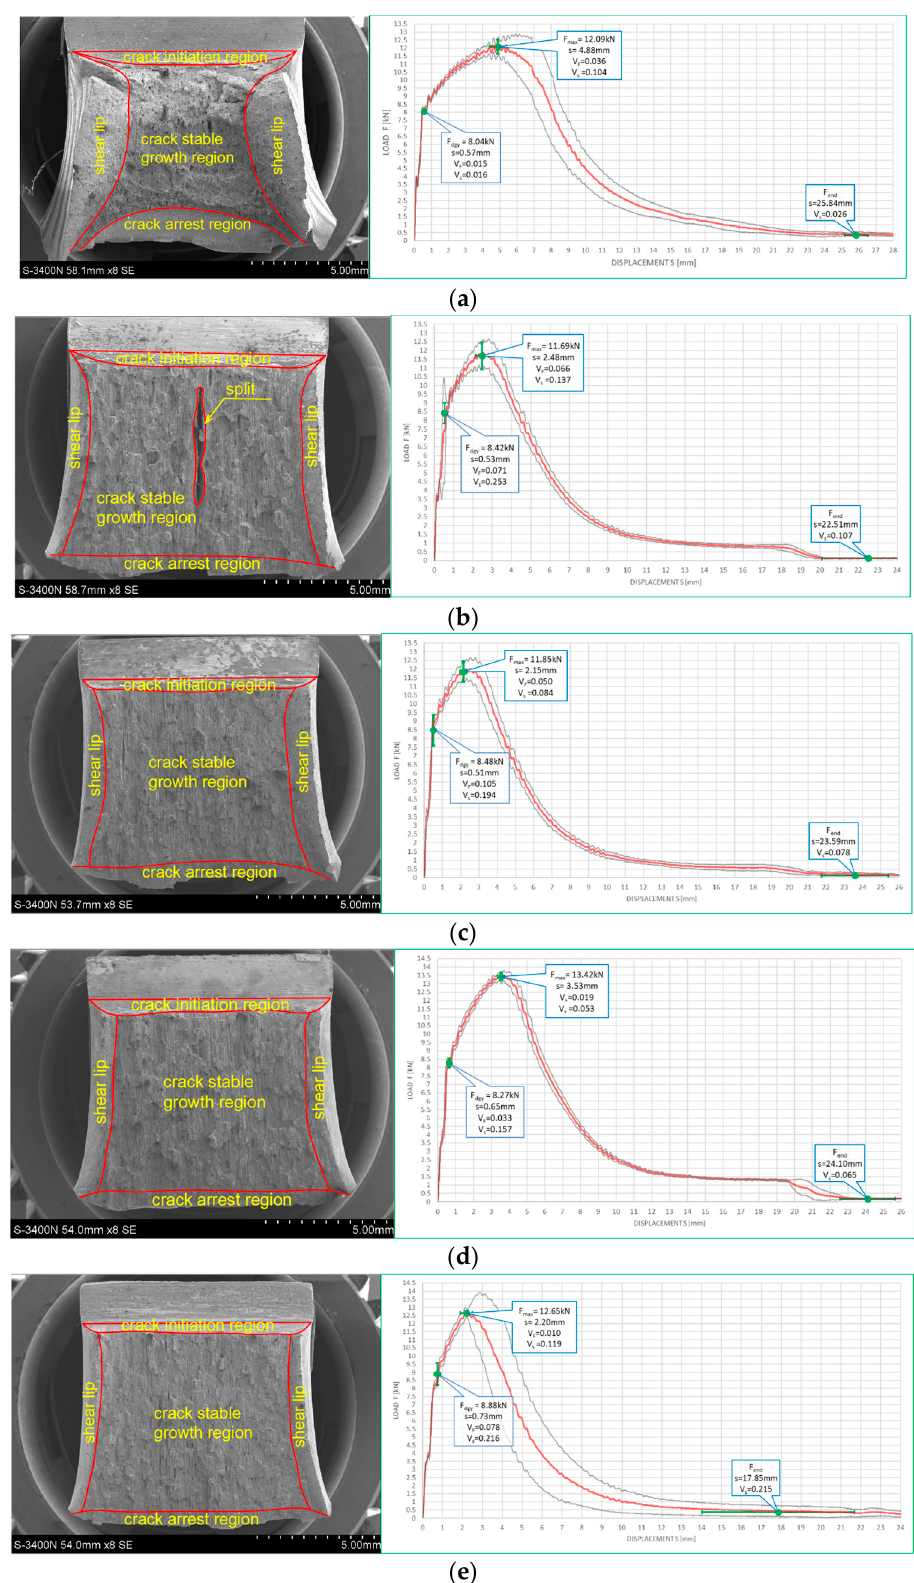
Figure 10. Morphology of the impact fractures obtained during the tests conducted at +20 °C on the samples made of S355J2+N steel—denotations follow the key listed in Table 1. ( a ) 1 (+20) ; ( b ) 160 (+20) ; ( c ) 161 (+20) ; ( d ) 180 (+20) ; ( e ) 181 (+20) .